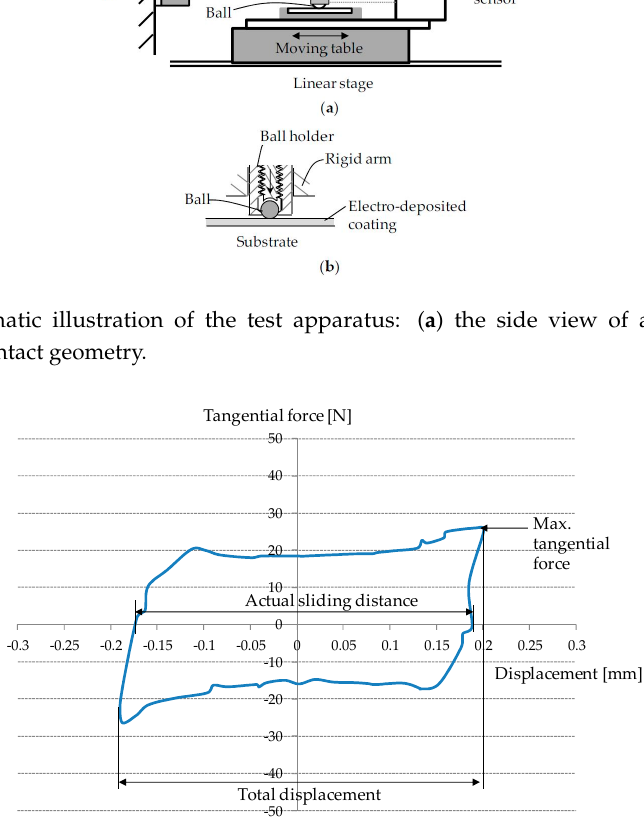
Figure 2. Fretting loop and definition of the maximum tangential force and sliding distance.